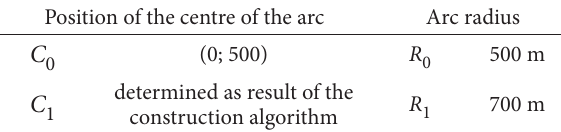
Fig. 9. Schema of C -shaped joining of the circular arcs using PH quintic Bezier curve Table 1. Parameters of the geometrical layout of two circular arcs Ω 0 and Ω 1 with a reverse curvature (i.e. sign k 1 ≠ sign k 2 )